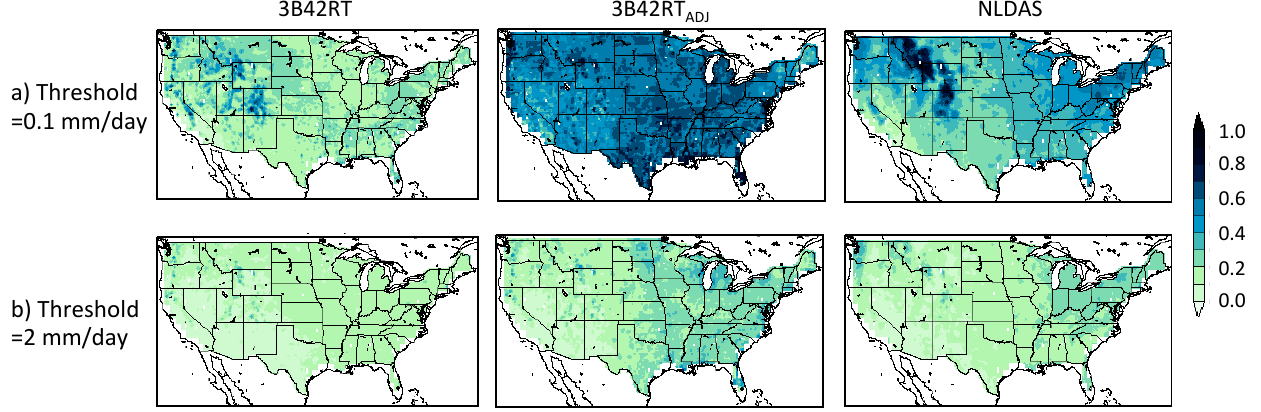
Figure 10. Frequency of rainy days in 3B42RT, 3B42RT ADJ and NLDAS with (a) 0.1mmday − 1 and (b) 2mmday − 1 rainfall threshold to define a rain day.